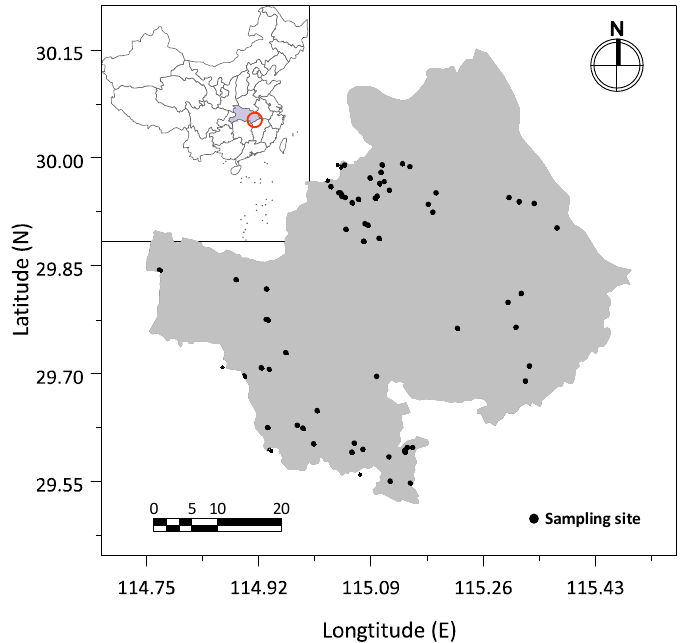
Figure 1. Distribution of soil sampling sites.